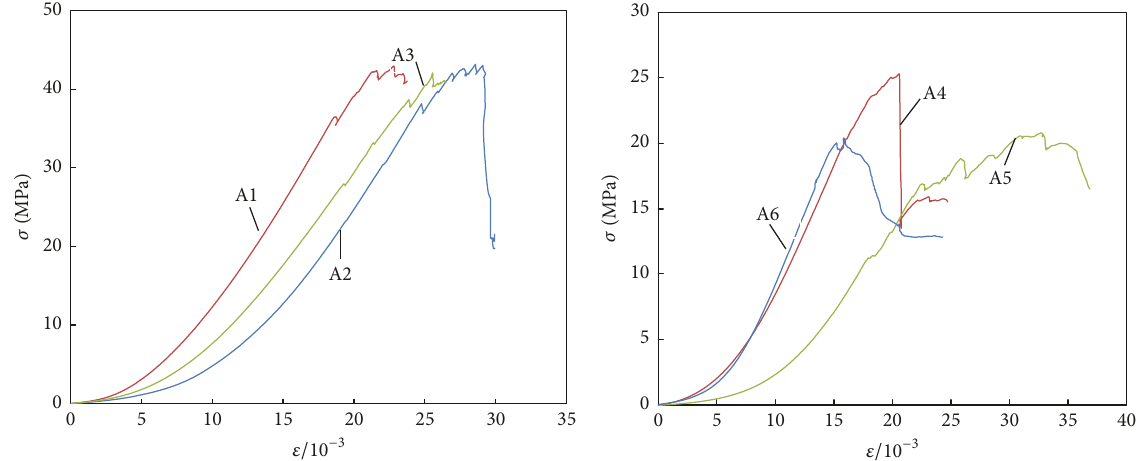
Figure 8: Stress-strain curves of natural and saturated coal samples under static